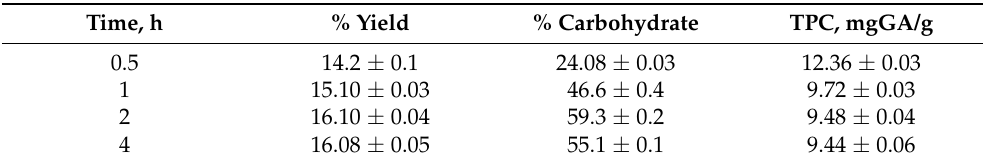
Table 1. Yield, carbohydrate, and total phenolic content (TPC; expressed as mg gallic acid/g) of the algal extracts at different extraction time